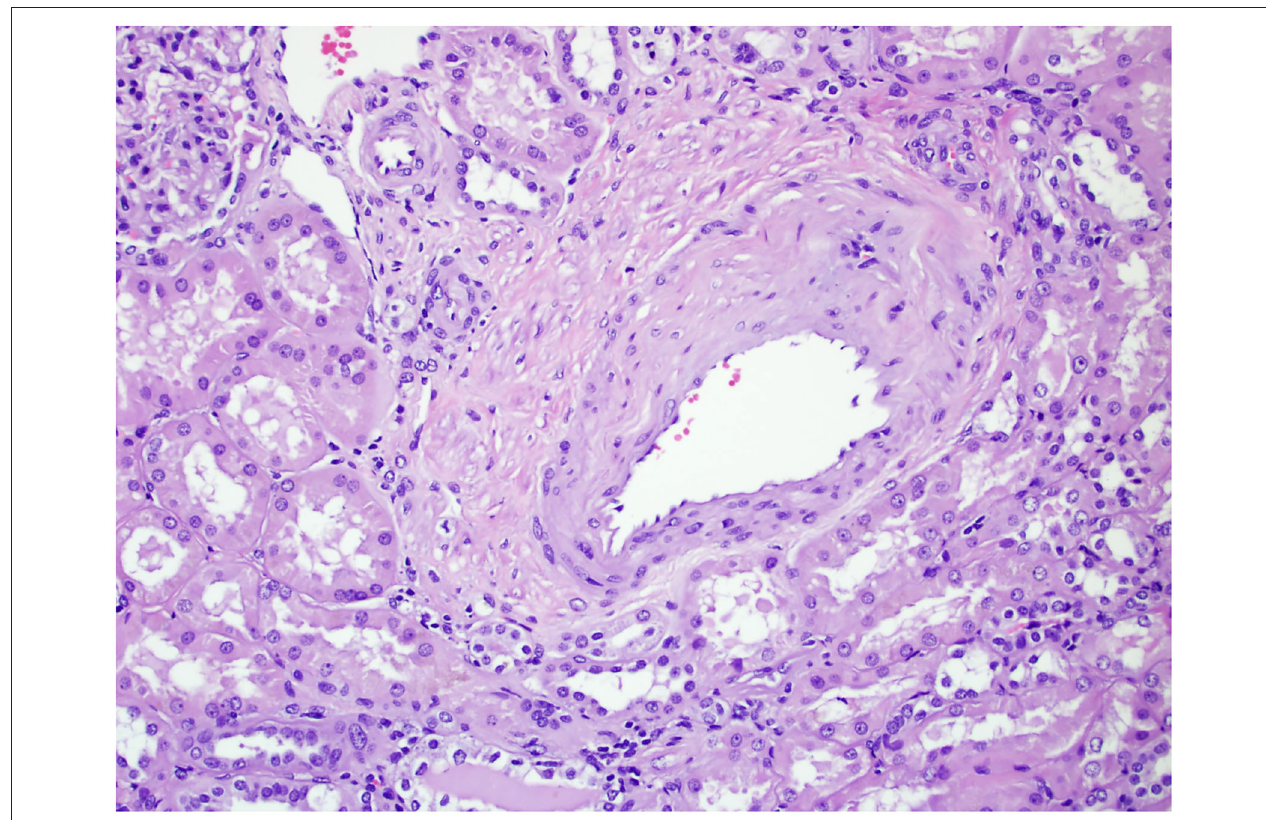
FIGURE 3 | The non-neoplastic renal tissue of a patient with VD on 200 × magnification. The figure shows renal arteriolar stenosis, evidenced by the narrowing of the vascular lumen and thickened vascular